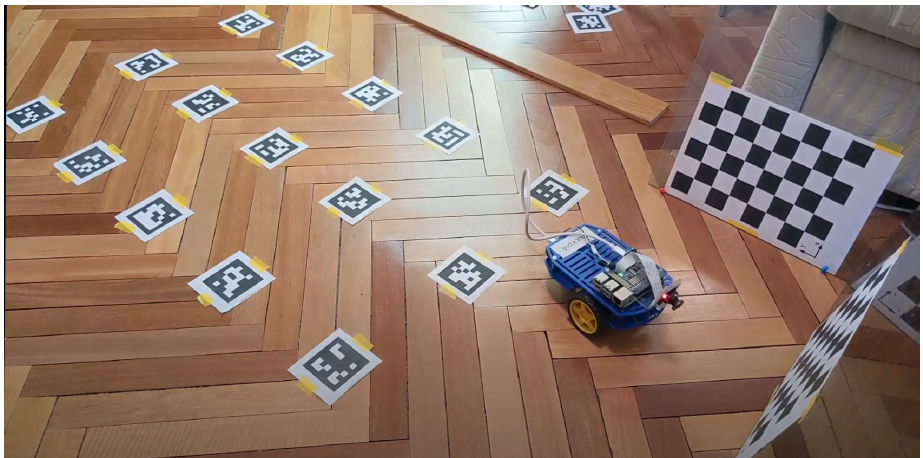
Figure 1. Initial position of the